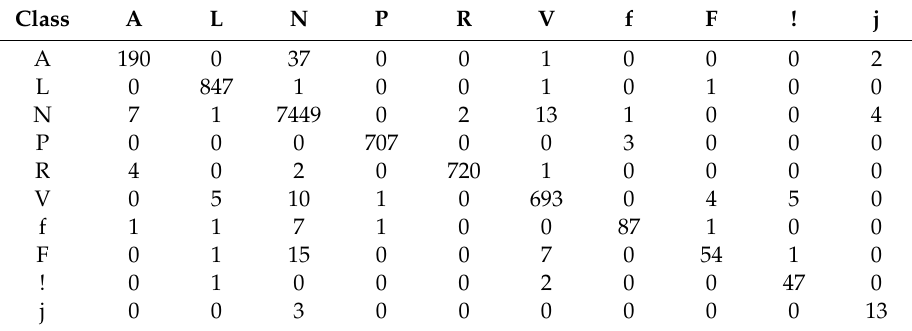
Table 7. Confusion matrix for testing process.